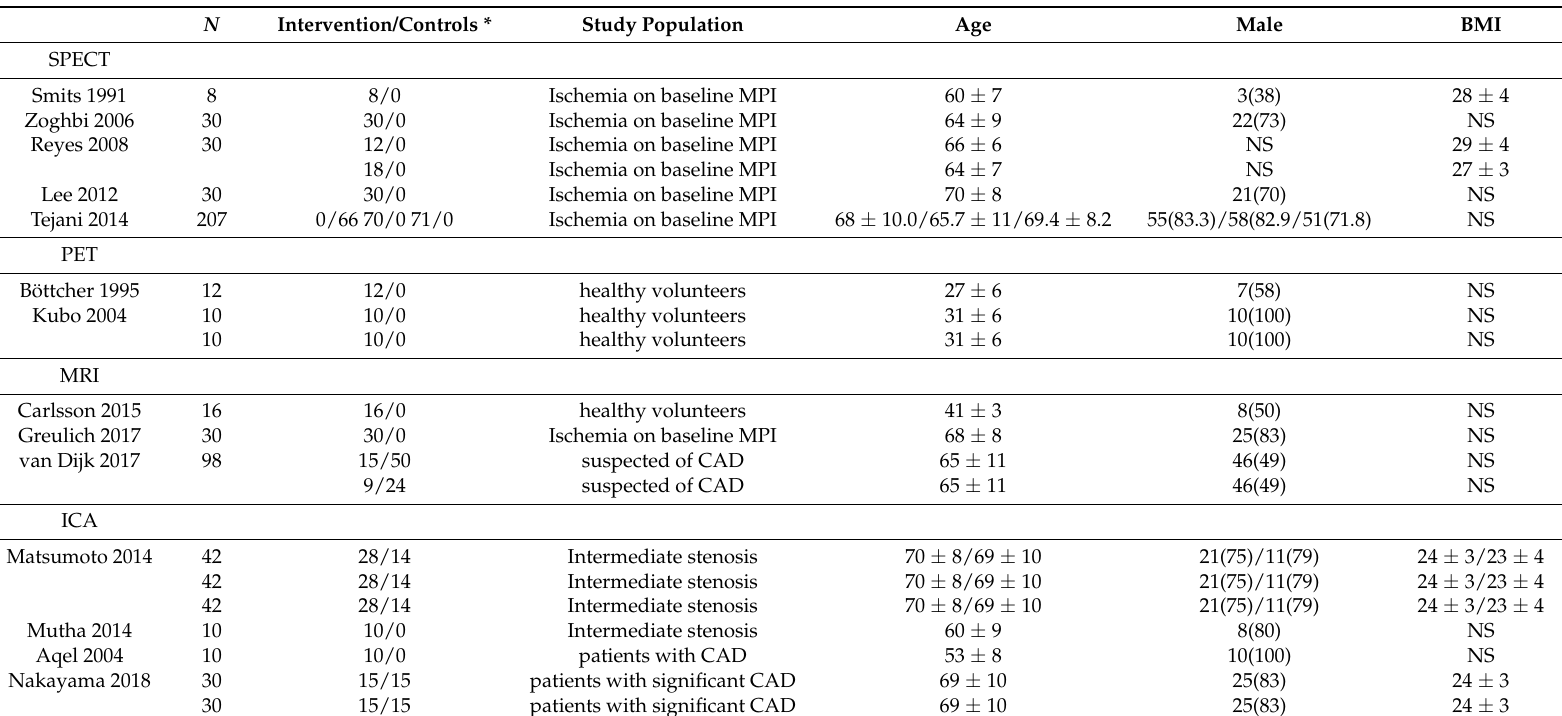
Table 1. Patient characteristics of the studies included in the systematic review. Variables either presented as n, mean ± SD or n (%). CAD: coronary artery disease; N : number of patients; BMI: Body mass index; MPI: Myocardial perfusion imaging. * Intervention/control: Number of patients with caffeine intervention/number of patients without caffeine